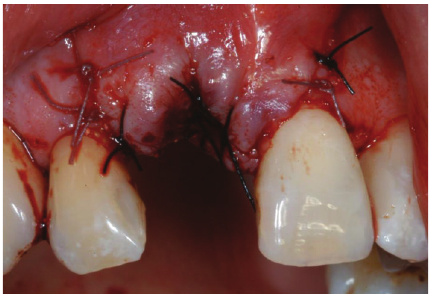
Figure 8: The flap was sutured in